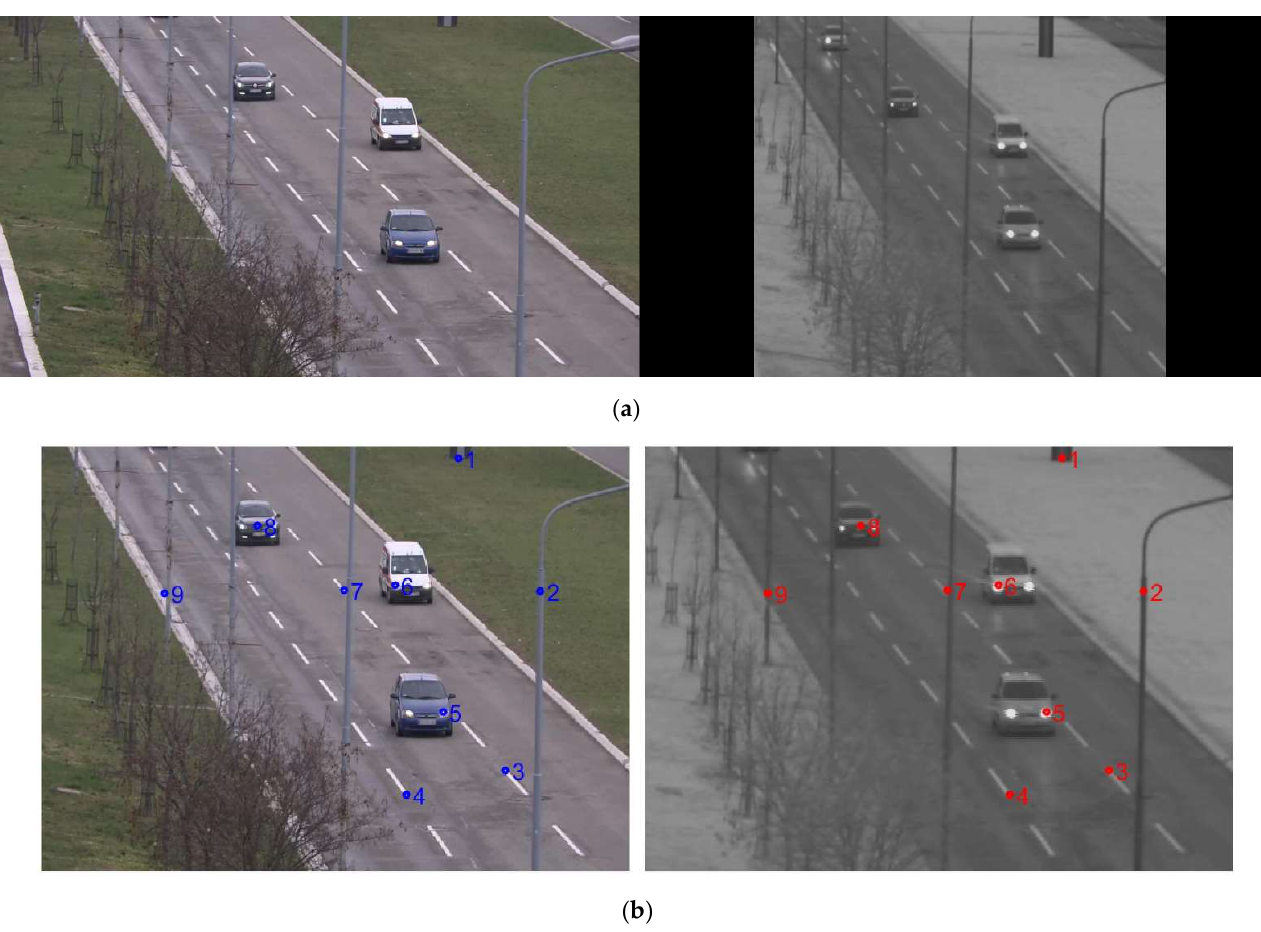
Figure 7. ( a ) Visible-light image (left) and SWIR image (right) of the same scene taken with the Vlatacom Multi-Sensor Imaging System (vMSIS3). ( b ) Images after synchronization and cropped in the overlap zone. Red points on the SWIR image represent the corresponding blue points mapped from the visible-light image.